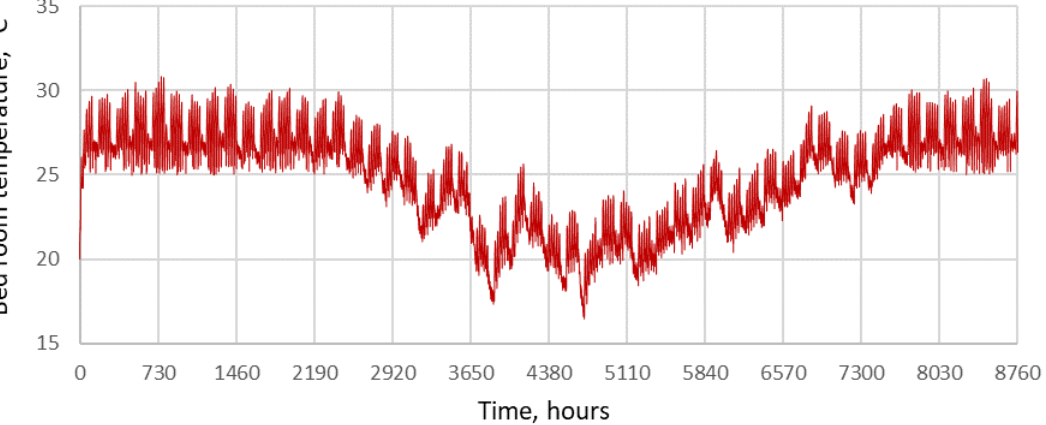
Figure 8. Bedroom temperature profile.